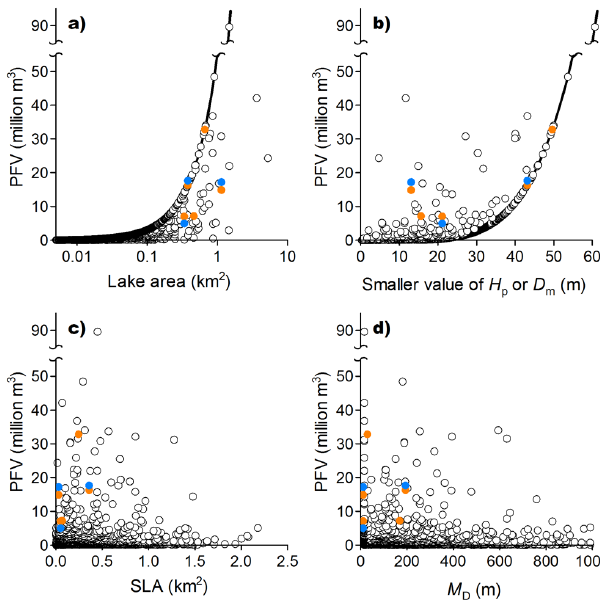
Fig. 12. Relationships of PFV with (a) lake area, (b) H p or D m (whichever is smaller), (c) SLA, and (d) M D for 2276 Himalayan glacial lakes (open circles). Abbreviations are shown in Table 1. Coloured circles indicate estimates based on the method developed in this study (orange) and by other approaches (blue) for the five training GLOF lakes (Fig. 5 and Table 1). Thick lines in (a) and (b) indicate PFV values constrained by Eq. (1), which is based on the maximum approximation of the lake’s mean depth (Fig.